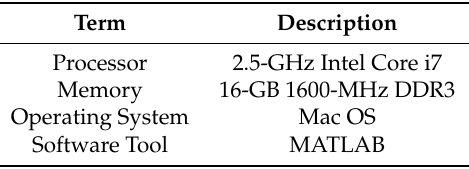
Table 1. Specification of the simulation